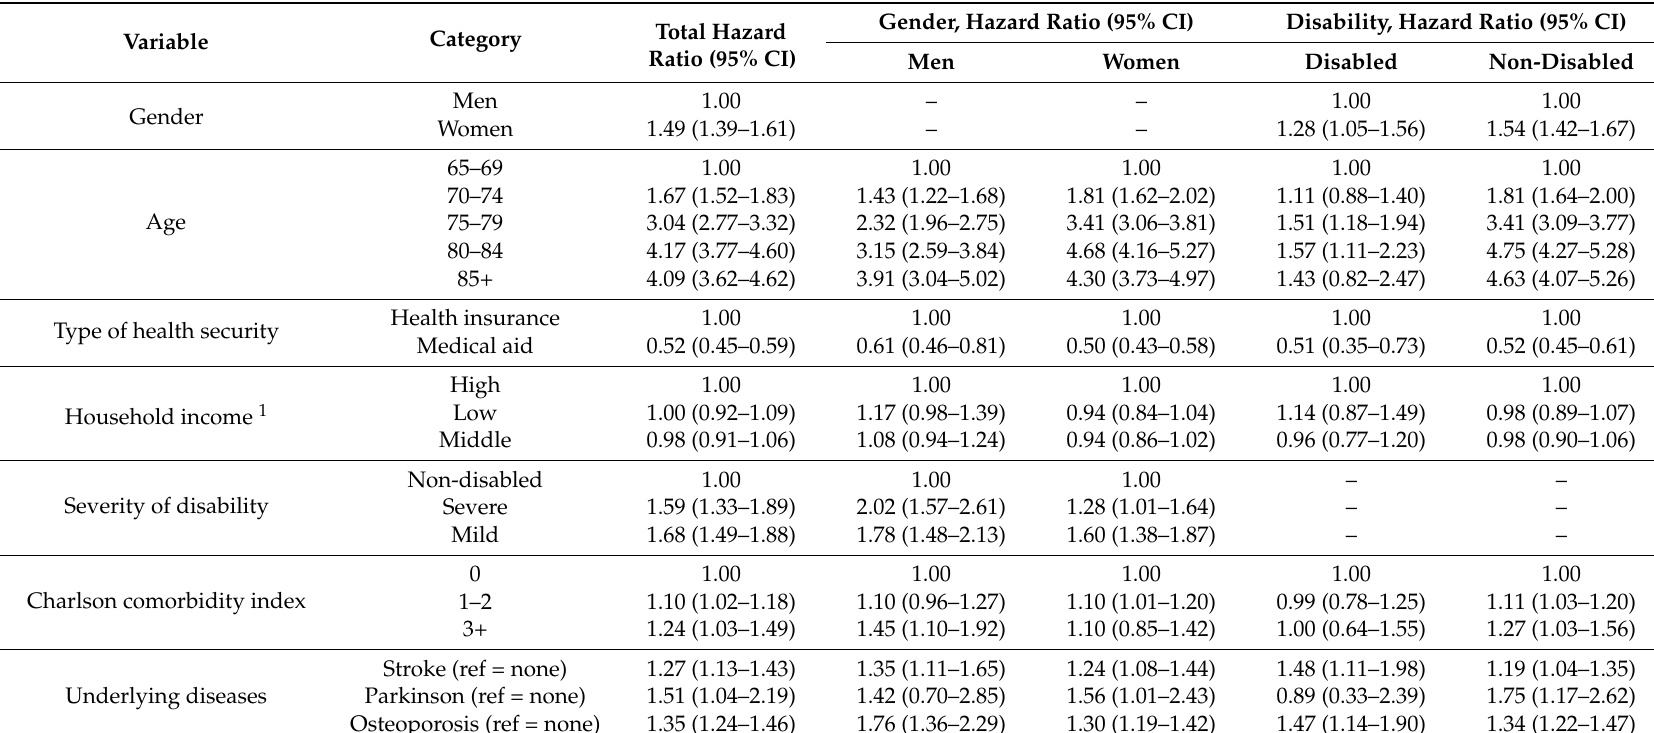
Table 3. Hazard ratios of associated factors with hip fracture and subgroup analysis according to gender and